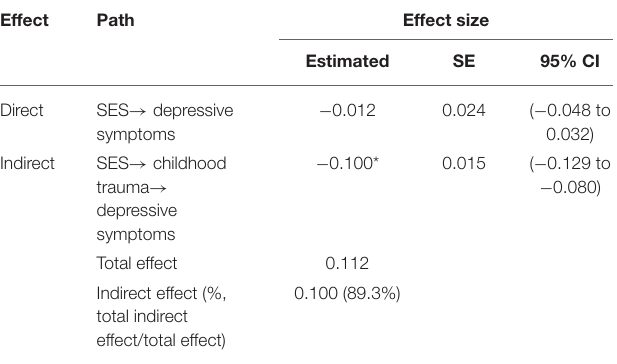
TABLE 3 | The analysis of paths and effects ( N =